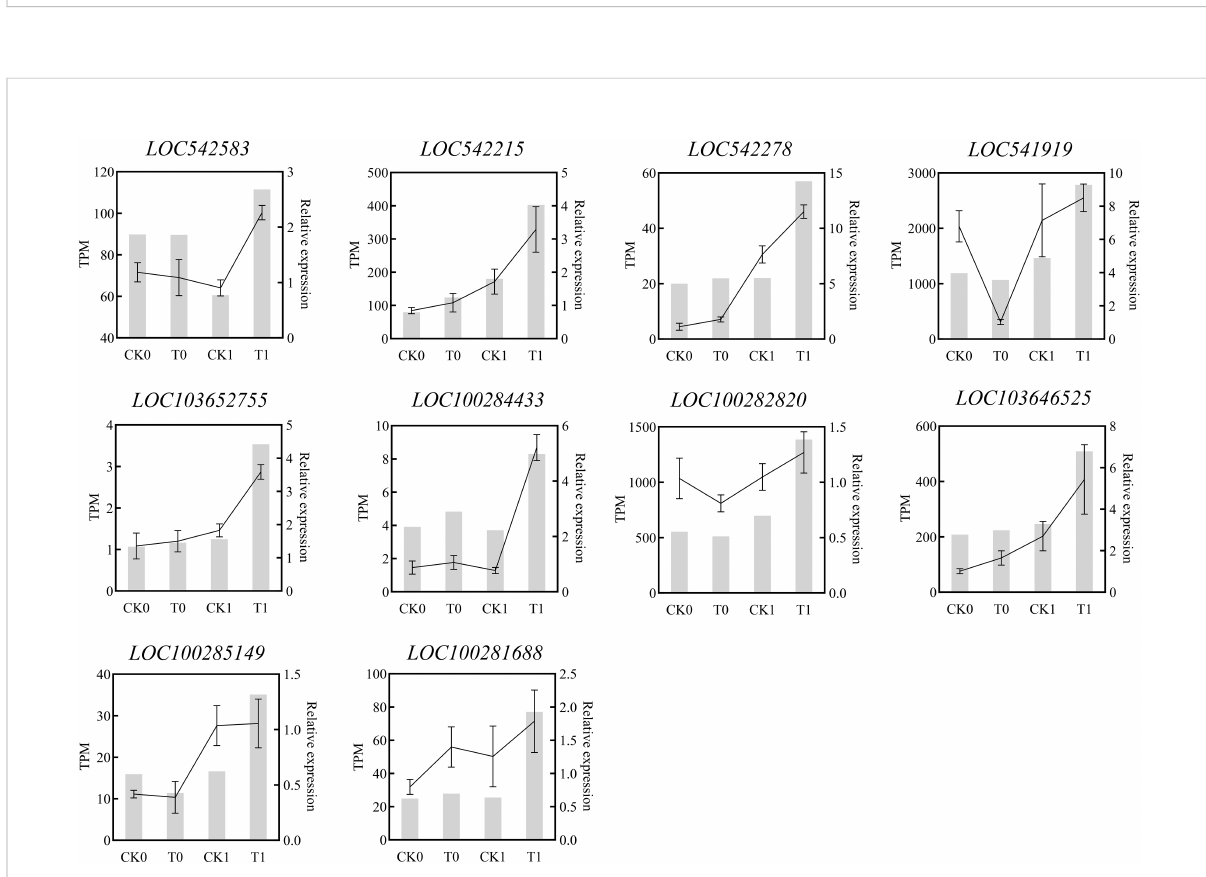
FIGURE 7 Quantitative real-time PCR (RT-qPCR) validation of the selected DEGsfrom RNA-seq analysis.The relative expression amount obtained by RT- PCR was expressed by broken lines. RT-qPCR data showed the mean values from three replicates, and the error bars represented the SEM of the means, while the corresponding expression data for RNA-seq were presented in the grey